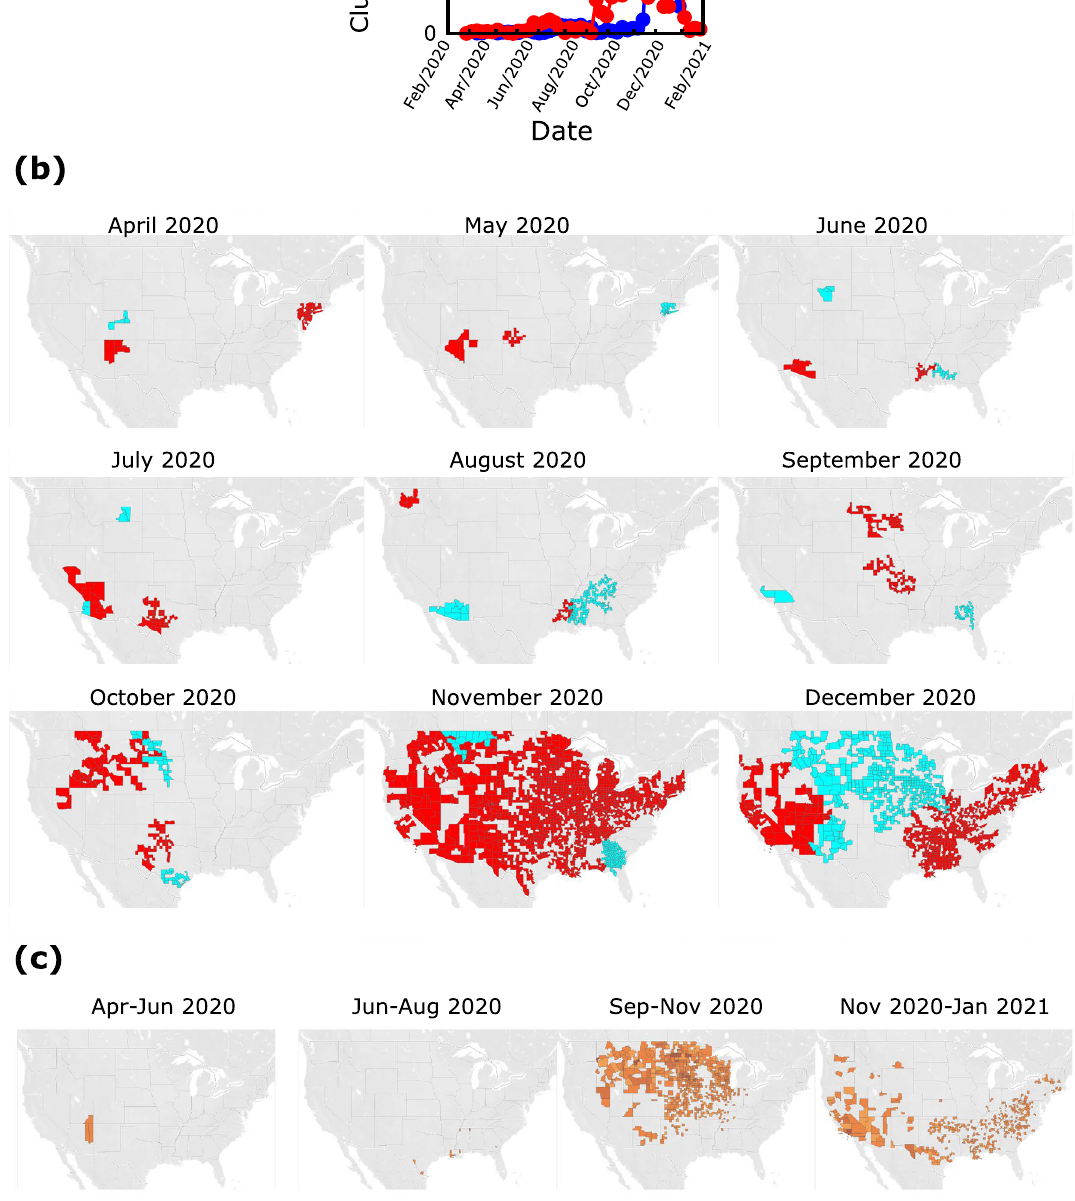
Figure 5. Clustering analysis of the correlations ( a ) Total area of the largest clusters as a function of time. The red line corresponds to clusters of increasing number of cases and the blue line corresponds to clusters of decreasing cases. ( b ) The maps show the two largest clusters with positive rate (red) and the two largest clusters of negative rate (blue) at different times. ( c ) ‘Persistence’ maps. These maps show the counties which remained in positive clusters for more than half of the time period indicated on the